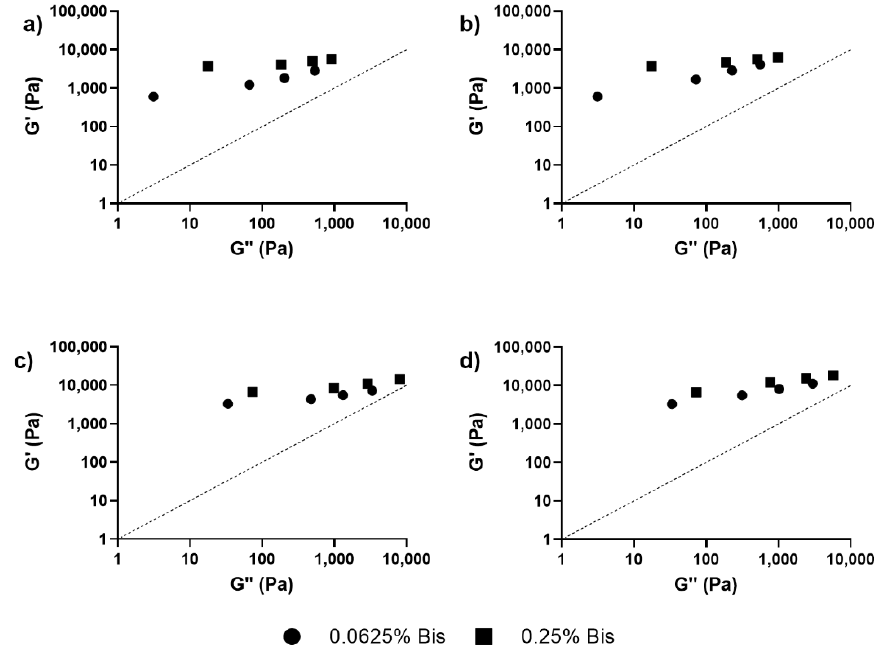
Figure 4. Han plots for pAAm hydrogels prepared using different concentrations of the Bis crosslinker —●: 0.0625% Bis and ■ : 0.25% Bis, and different concentrations of Dex — 0, 0.5, 1, and 2%, with increasing concentration going from left to right in each plot, and ( a ) 0% SiNPs and 100 kDa Dex, ( b ) 0% SiNPs and 500 kDa Dex, ( c ) 2% SiNPs and 100 kDa Dex, ( d ) 2% SiNPs and 500 kDa Dex.